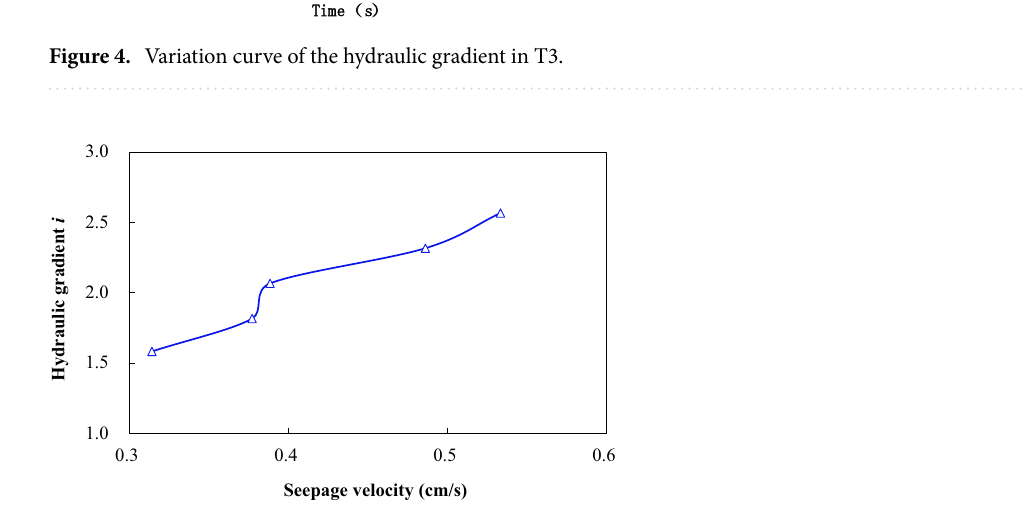
Figure 5. Variation curve of the hydraulic gradient and seepage